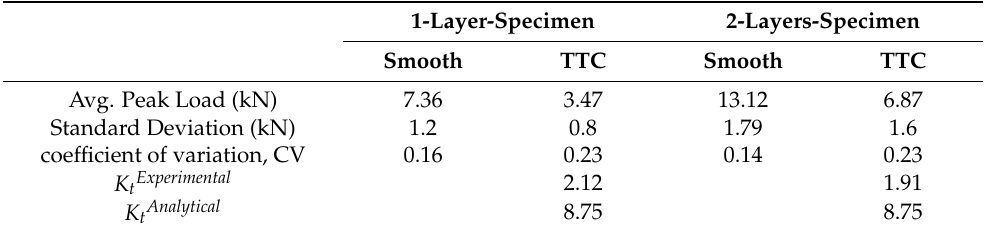
Table 6. The experimental and numerical stress concentrator factors ( K tExperimental ) & ( K tAnalytical ), respectively, for TTC specimens of ASTM